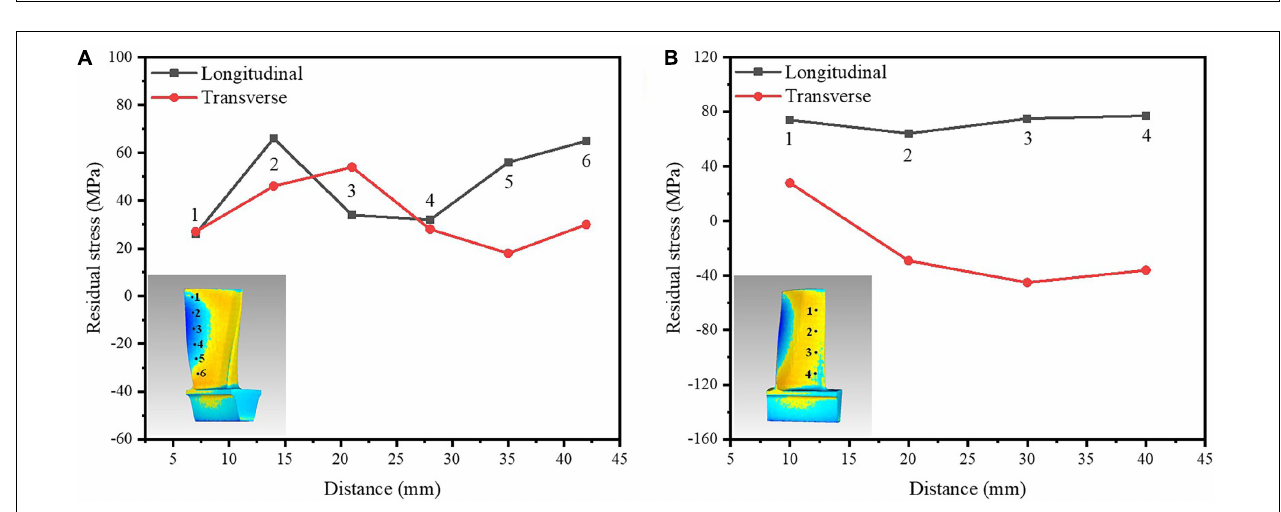
FIGURE 12 | Residual stress of the blade, (A) the trailing edge, (B) the leading edge.